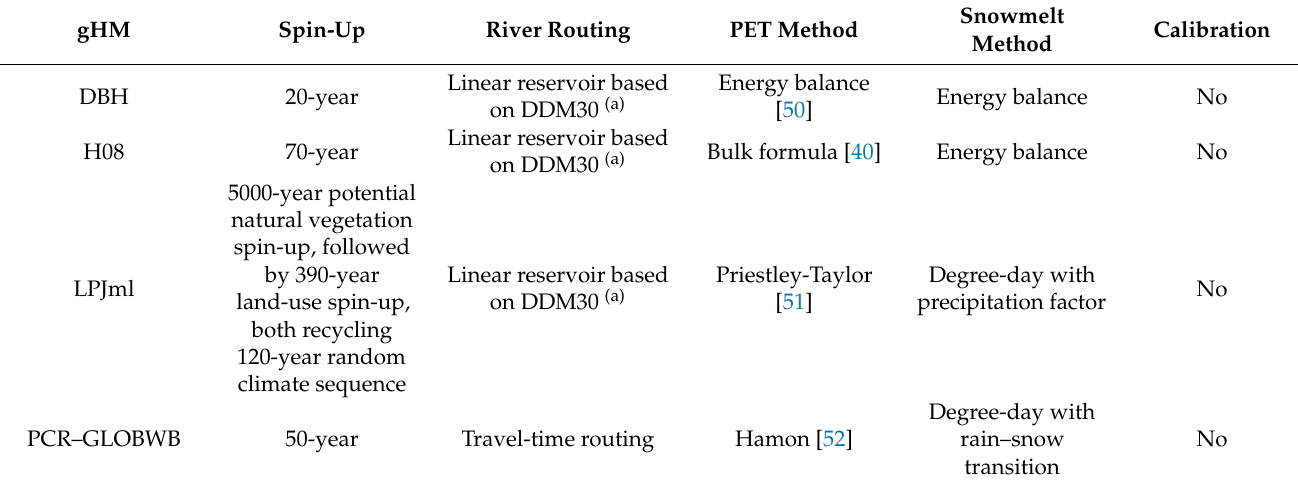
Table 2. Characteristics of the four gHMs used in this study. Each gHM, at the beginning of 1971, was stabilized (spin-up) using pre-1970 data. (a) See [49] for the DDM30 data used for the river routing in DBH, H08, and LPJml. Note that the energy balance for estimating snowmelt simulates energy and mass exchanges between internal layers of the snowpack as well as snowpack stratigraphy from physically based calculations using simulated meteorological